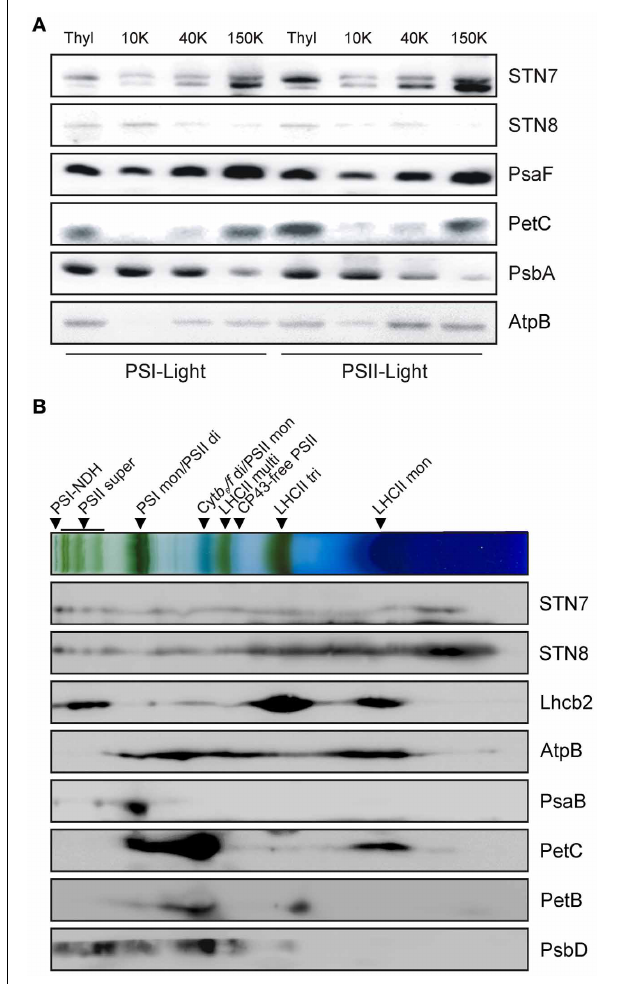
FIGURE 3 | Localization of the STN kinases within the thylakoid membrane. (A) Analysis of STN7 and STN8 localization by thylakoid membrane sub-fractionation. Thylakoids of PSII- or PSI-light adapted WT plants were fractionated into grana lamellae (10K), grana margins (40K) and stroma lamellae (150K) by differential ultracentrifugation after digitonin solubilization. Proteins were separated by SDS-PAGE and analyzed by immunolabeling using antibodies against STN7, STN8, PsaF, PetC, PsbA, and AtpB. (B) Analysis of STN7 and STN8 distribution by 2D BN/SDS-PAGE. Thylakoid membranes of WT equivalent to 50 μ g of Chl were solubilized with β -DM, subjected to 2D BN/SDS-PAGE and analyzed by Western blotting. STN7, STN8 and various subunits of the major photosynthetic complexes (AtpB, Lhcb2, PsaB, PetC, PetB, and PsbD) were detected with specific antibodies. Protein-Chl complexes are indicated by black arrowheads. The bands detected were identified as specific protein complexes in accordance with previously published profiles (Armbruster et al., 2013): PSI-NDH supercomplex (PSI-NDH), PSII supercomplexes (PSII super), PSI monomers and PSII dimers (PSI mon and PSII di), PSII monomers and dimeric Cyt b 6 /f (PSII mon and Cyt b 6 /f di), PSII monomers w/o CP43 (CP43-free PSII), multimeric (LHCII multi), trimeric (LHCII tri), and monomeric (LHCII mon)